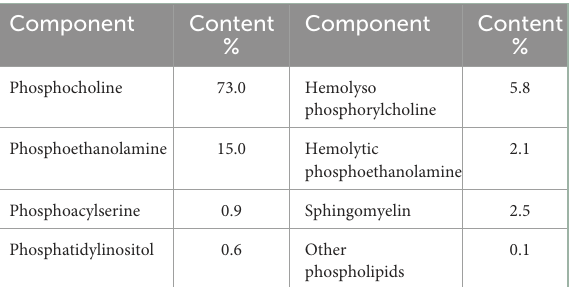
TABLE 1 Phospholipid composition of egg yolk.